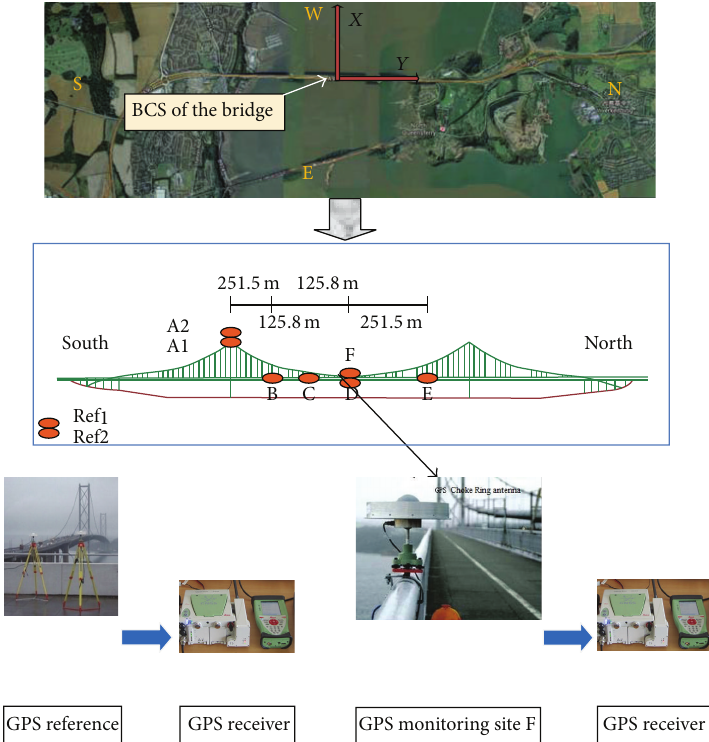
Figure 1: The devices used to monitor the dynamic responses of the Forth Road Bridge (only the data from site F will be analysed). 00.511.5